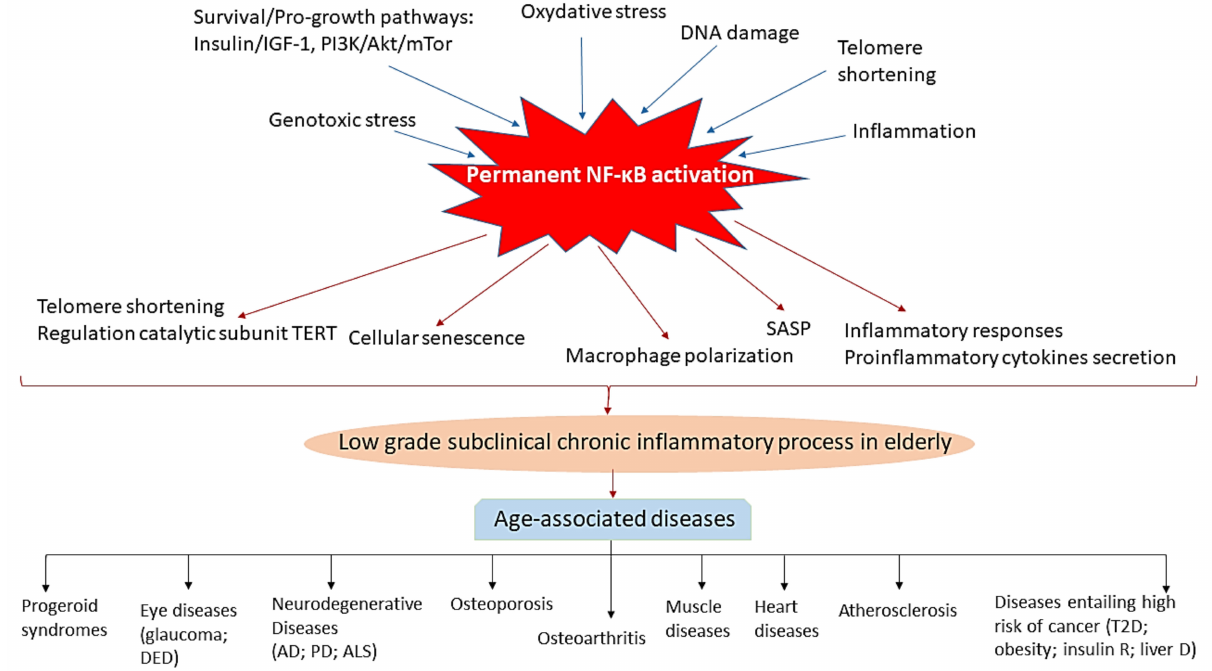
Figure 2. Schematic illustration highlighting the central role of chronic NF- κ B activation in inflammation in the elderly and in the development of age-related diseases. Factors known to promote aging phenotypes, such as pro-growth and survival pathways, genotoxic and oxidative stress, DNA damage, telomere shortening and inflammation activate NF- κ B. NF- κ B in turn acts to promote ageing-related changes by contributing to telomere shortening and positive regulation of the catalytic subunit TERT, cellular senescence, macrophage polarization toward an inflammatory M1 phenotype, proinflammatory secretion of cytokines, mainly TNF α and IL6, and inflammatory responses, which originate a subclinical chronic inflamma- tory status in aged individuals which can lead to the development of diverse age-associated diseases, including shortening of life-span, progeroid syndromes; eye diseases (glaucoma, DED (dry eye disease etc.), neurodegenerative diseases (AD, Alzheimer’s disease; PD (Parkinson’s disease); ALS (amyotrophic lateral sclerosis) etc.), osteoporosis, osteoarthritis, muscle and heart diseases, atherosclerosis and other disorders such as type 2 diabetes (T2D), obesity and insulin resistant, and hepatic diseases, which have associated an increased risk of developing